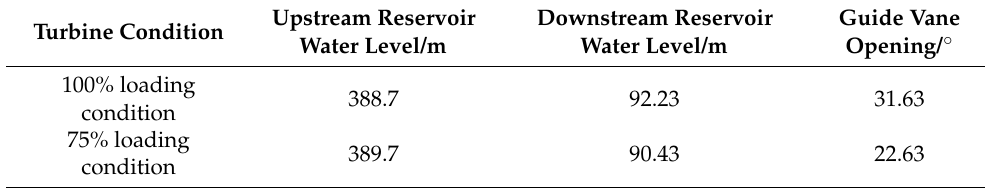
Table 3. Details of different conditions.